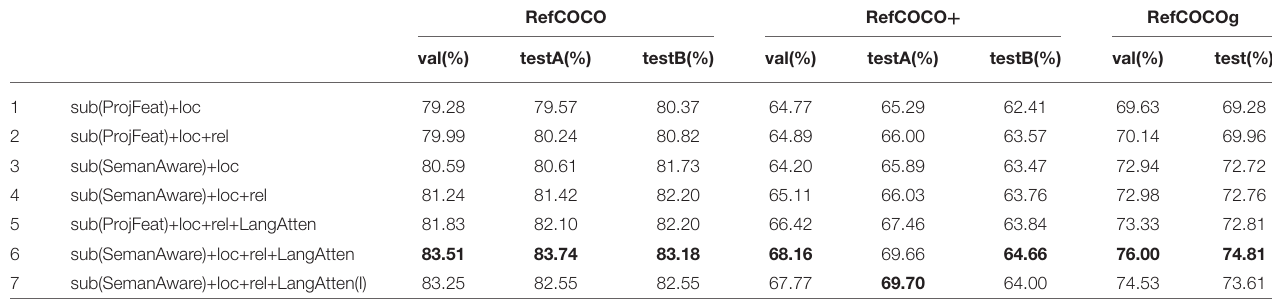
TABLE 1 | Ablation studies of our model using different module combinations.